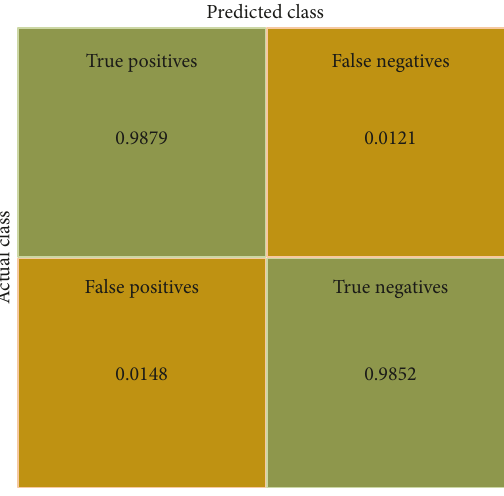
Figure 10: Confusion matrix of the proposed system.